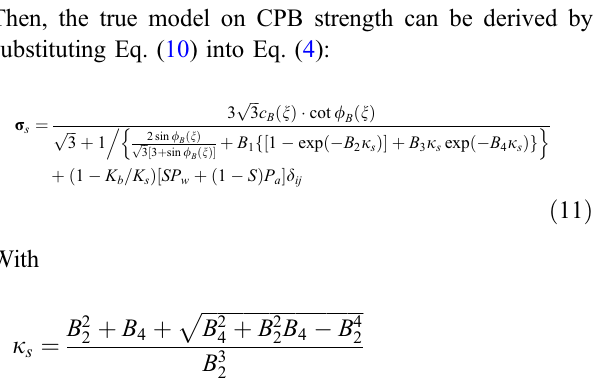
B 4 (cid:2) B 4 2